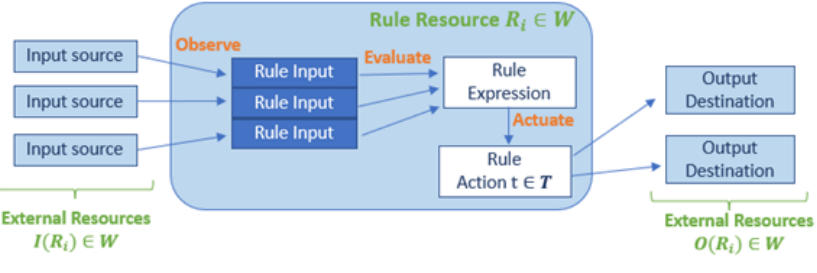
Figure 1. Rule resource